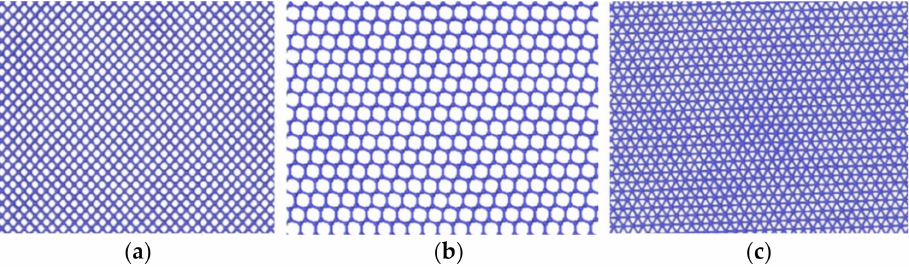
Figure 8. The key structure in the direction of the loaded surface. ( a ) (001) surface; ( b ) (110) surface; ( c ) (111) surface.